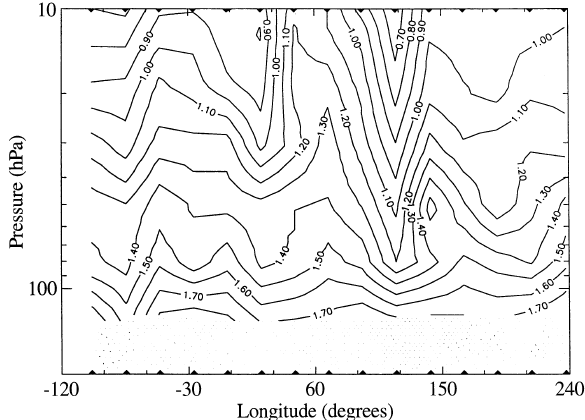
Fig. 8. Observations by HALOE at sunset on November 22, 1995 at 47 (cid:14) N. CH 4 mixing ratios (in ppmv) are shown against pressure and longitude. The black triangles indicate the longitude of the HALOE measurements